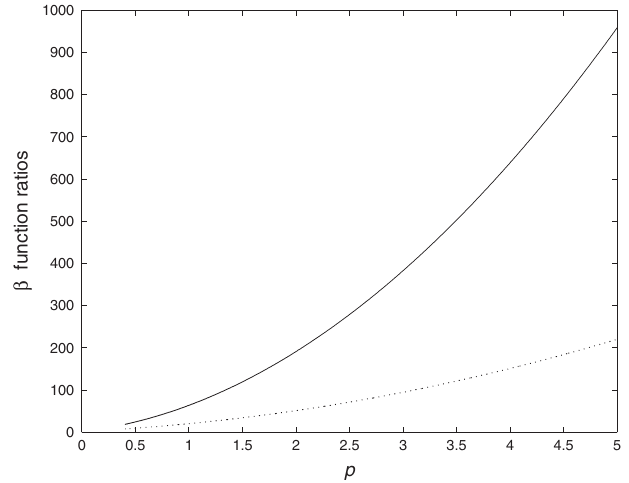
FIG. 1. The horizontal and vertical beta function ratios at the focusing quadrupole (dashed line) and the center of the straight section in between of the defocusing quadrupoles (solid line) as a function of the variable straight section length p